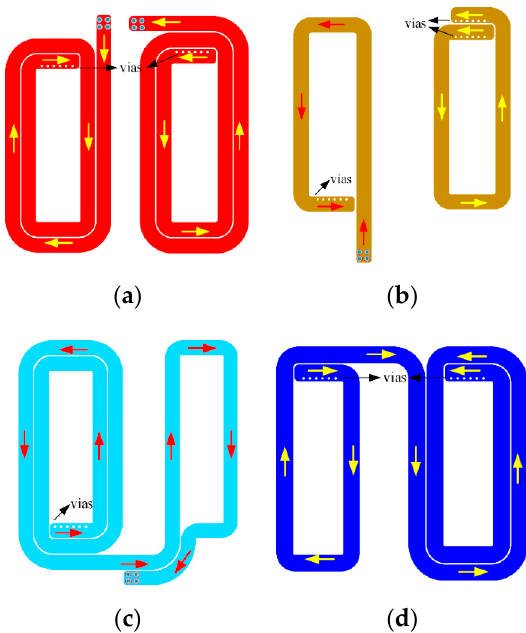
Figure 9. Winding arrangement for transformer T 2 ( a ) Layer 1, ( b ) Layer 2, ( c ) Layer 3, ( d ) Layer 4.